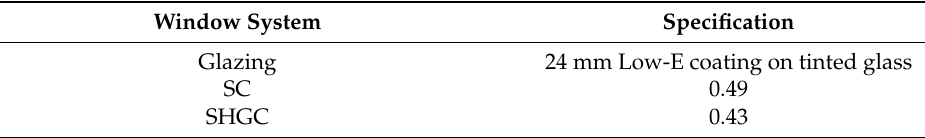
Figure 4. The building model for the energy simulation. Table 3. Specifications for the window systems. Table 2. Specifications for the energy simulation.